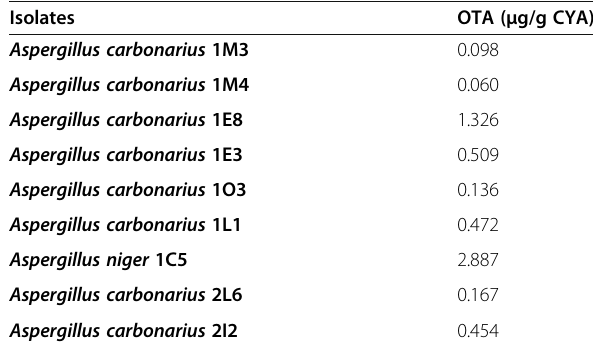
Table 2 OTA potential after 7 days incubation at 25 °C on CYA of dried grapes ’ isolates